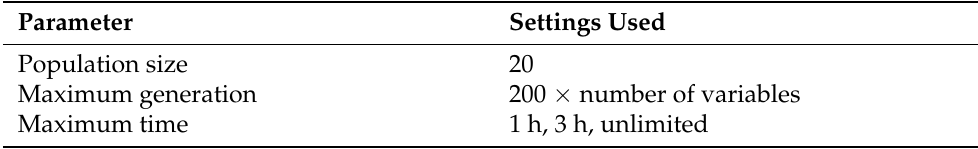
Table 5. Parameters used for genetic algorithm